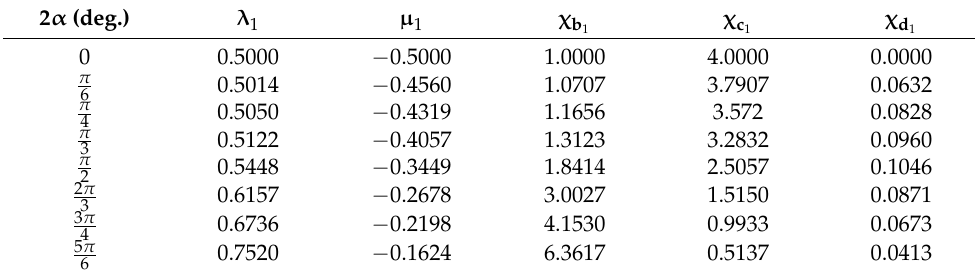
Table A1. Eigenvalues for different notch opening angles in mode I loading [60].